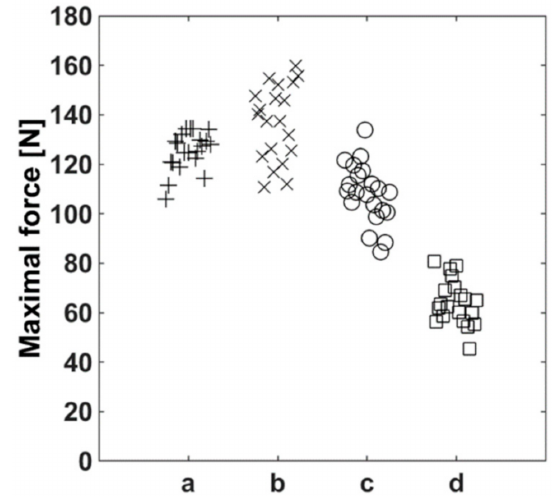
Figure 3. Retest-reliability of the four securements (20 measurement repetitions). ( a ) Sterile wound dressingcoveredbytwoelasticpolyesterfleecedressings, oneincised; ( b )sterilewounddressingcovered by two elastic polyester fleece dressings, both incised; ( c ) non-bordered transparent polyurethane film dressing; ( d ) bordered polyurethane film dressing (nonwoven polyester with polyurethane film